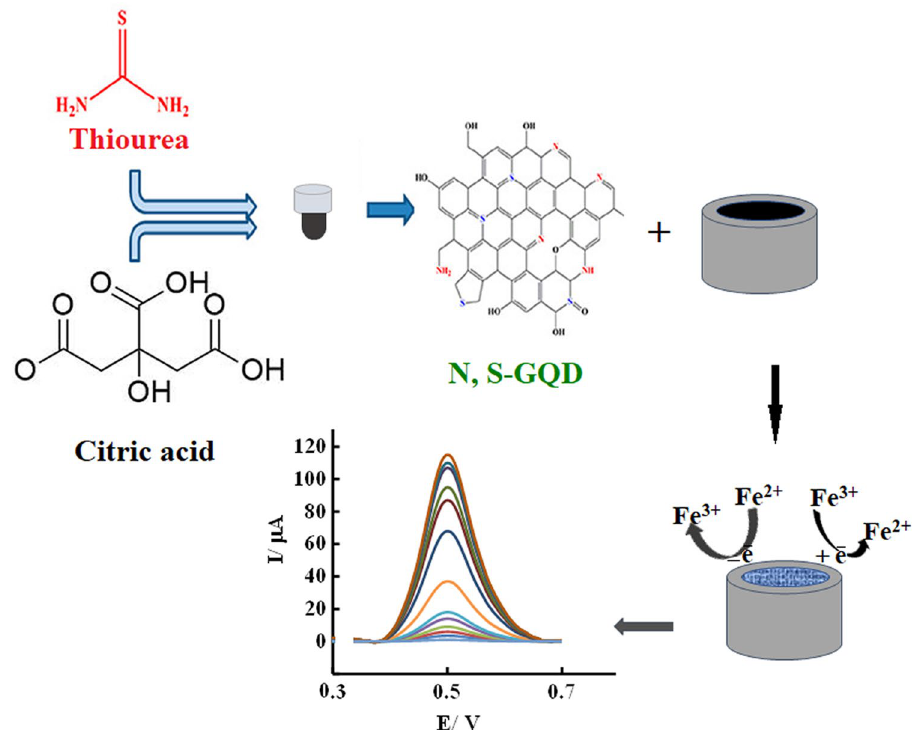
Figure 1. Schematic illustration of synthesis and application of N, S-GQD in Fe ions